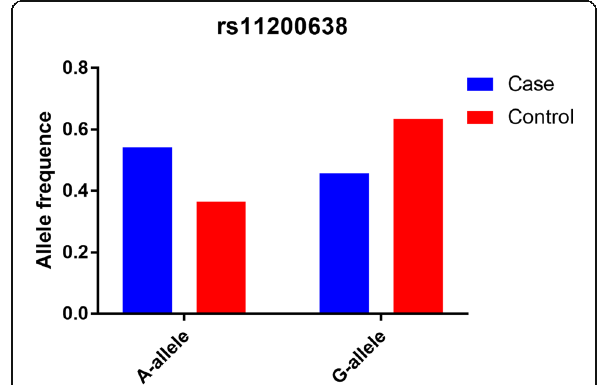
Fig. 2 The MAF of minor-allele (mutant-allele) for HTRA1 gene rs11200638 polymorphism from the 1000 Genomes online database and present analysis. EAS: East Asian; EUR: European; AFR: African;